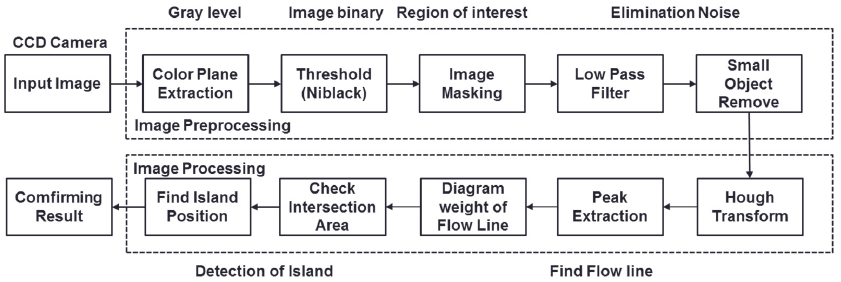
Figure 3. Image processing procedure to find the center point of the spoke pattern.